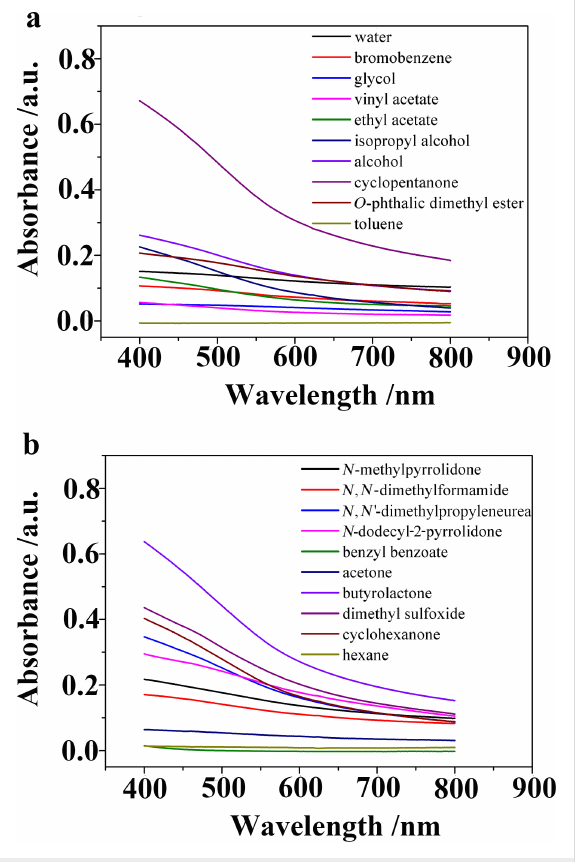
Figure 3: UV − visible spectrum of the KP 15 dispersions using various solvents.